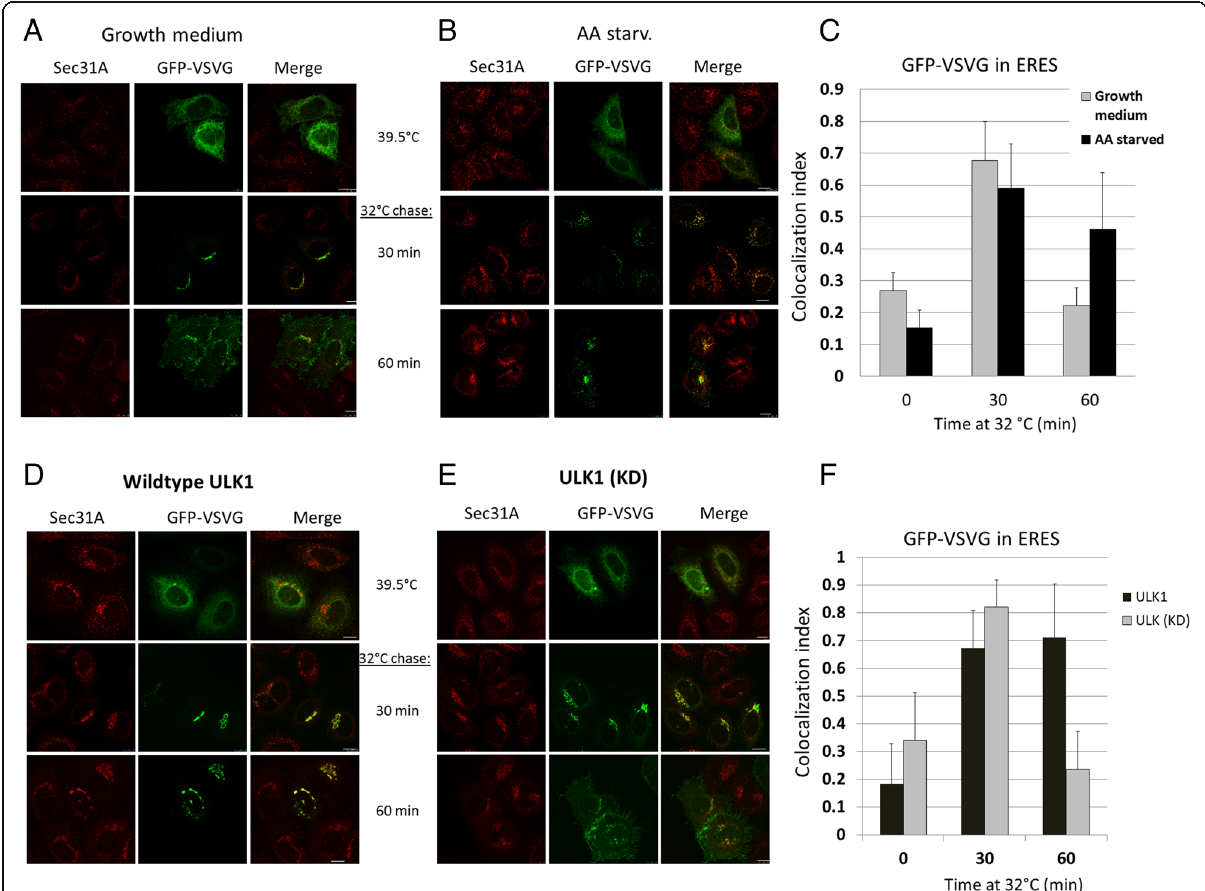
Fig. 3 Autophagy and ULK1 caused retention of transport marker VSVG in ERESs. a Hela cells were transfected with GFP-VSVG-tsO45 and the cells were kept at 39.5C overnight. Then the cells were cultured in ( a ) normal growth medium or ( b ) induced with autophagy by amino acid starvation for 2 h before the incubation temperature was shifted to 32 °C for the indicated time to chase the VSVG out of the ER. c Quantification of the ERES-associated VSVG signals. The fractions of VSVG signal in ERES at different time points after 32 °C chase were measured by Manders Coefficients. Number of cells ≥ 10; Error Bars = S.D. d Hela cells were transfected with GFP-VSV-G tsO45 and Myc-ULK1 or ( e ) its kinase dead mutant at 1:4 ratio and the cells were kept at 39.5 °C. After being chased at 32 °C for different times as indicated, the cells were fixed and stained with Sec31A for ERES. f Quantification of the amount of ERES-retained VSVG signal in ULK1 or kinase dead mutant. The fractions of VSVG signal in ERES at different time points after 32 °C chase were measured by Manders Coefficients. Number of cells ≥ 8; Error Bars = S.D., p <